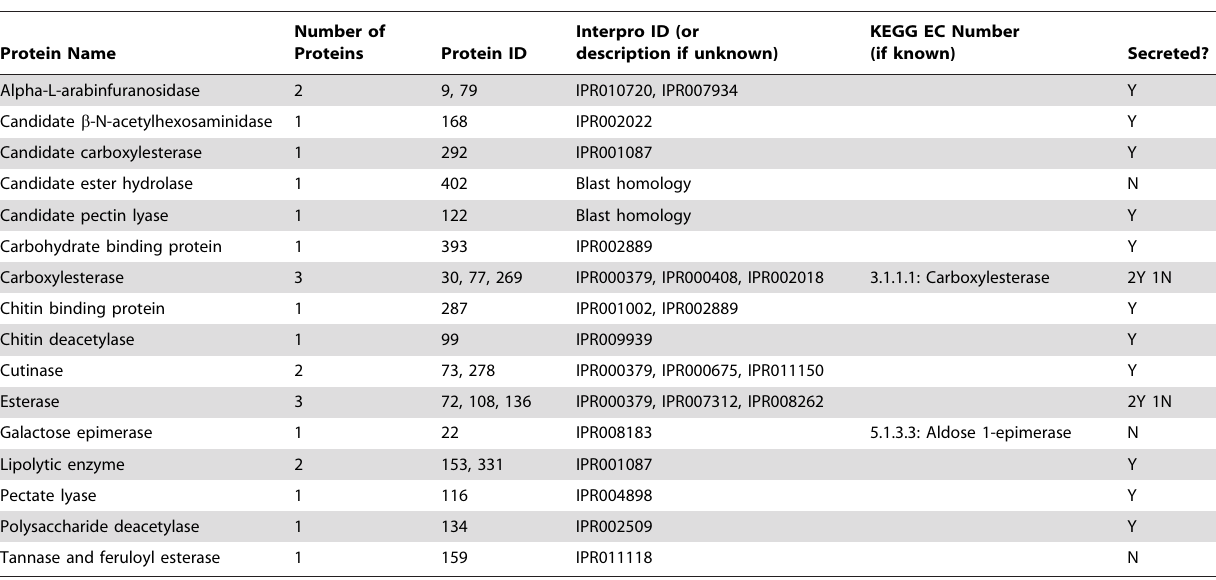
Table 4. Other cell wall degrading proteins from MudPIT analysis.